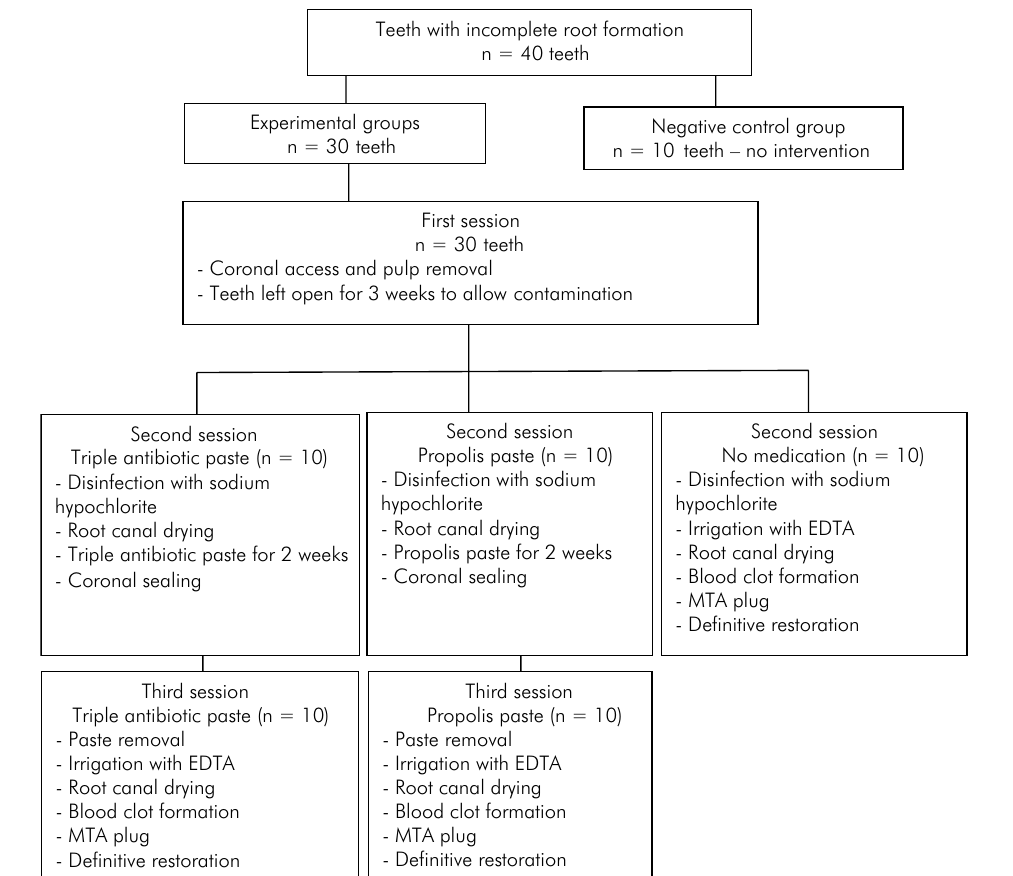
Figure 1. Experimental design and study